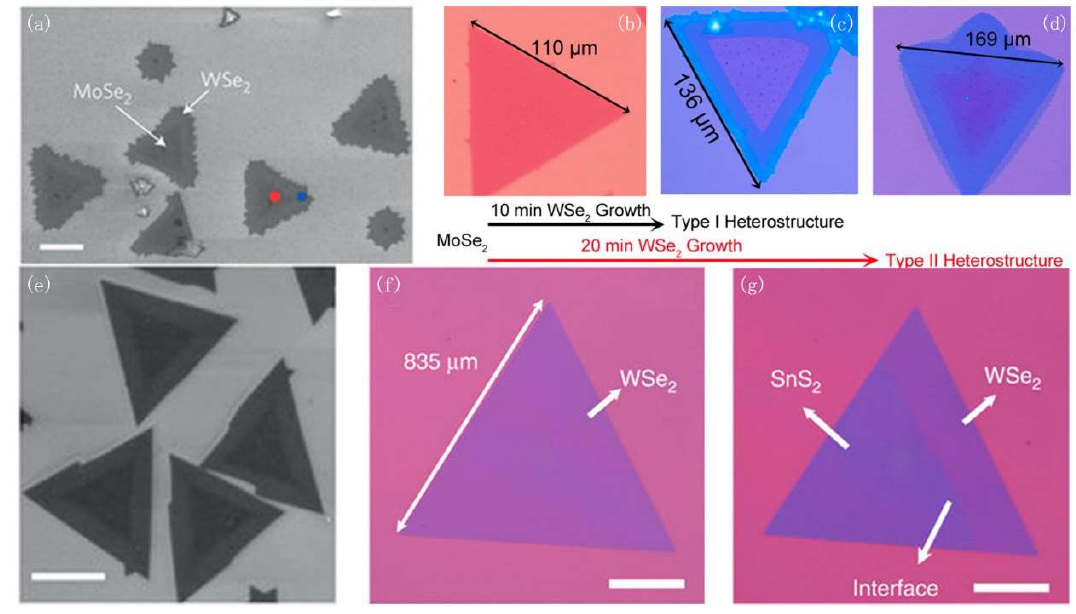
Figure 4. Synthesis of 2D material heterojunction. ( a ) Scanning electron microscope (SEM) image of